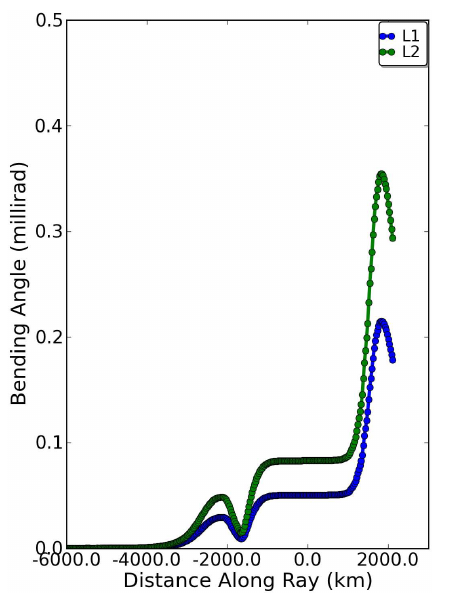
Fig. 7. Bending angle along the ray for the L1 and L2 frequencies, assuming GAIM electron density distribution. Compare to Fig. 4.